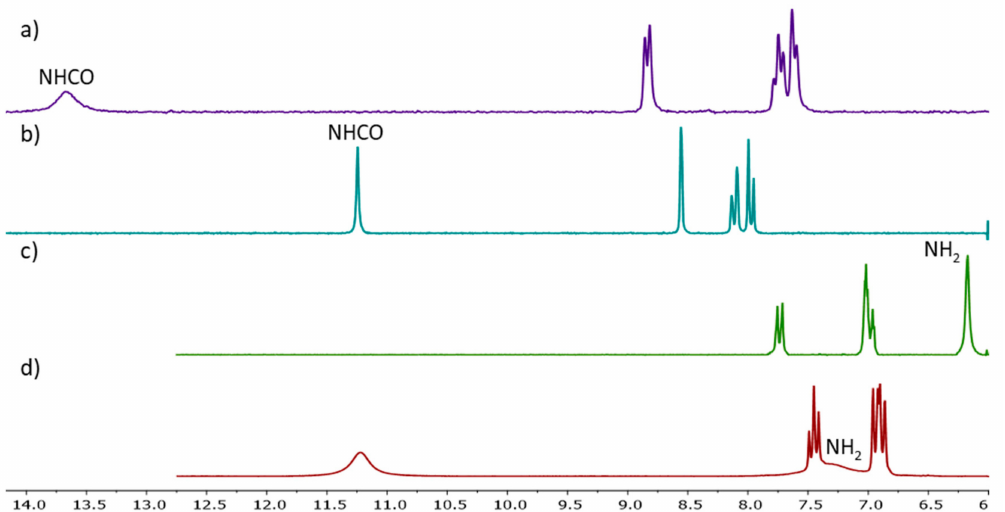
Figure 1. 1 H-NMR (200 MHz, DMSO- d 6 ) spectra of: ( a ) 1e ; ( b ) 12b ; ( c ) isoluminol; and ( d ) luminol (aromatic region). The signals attributed to 5- N -amide ( a , b ) and amine ( c , d ) protons are